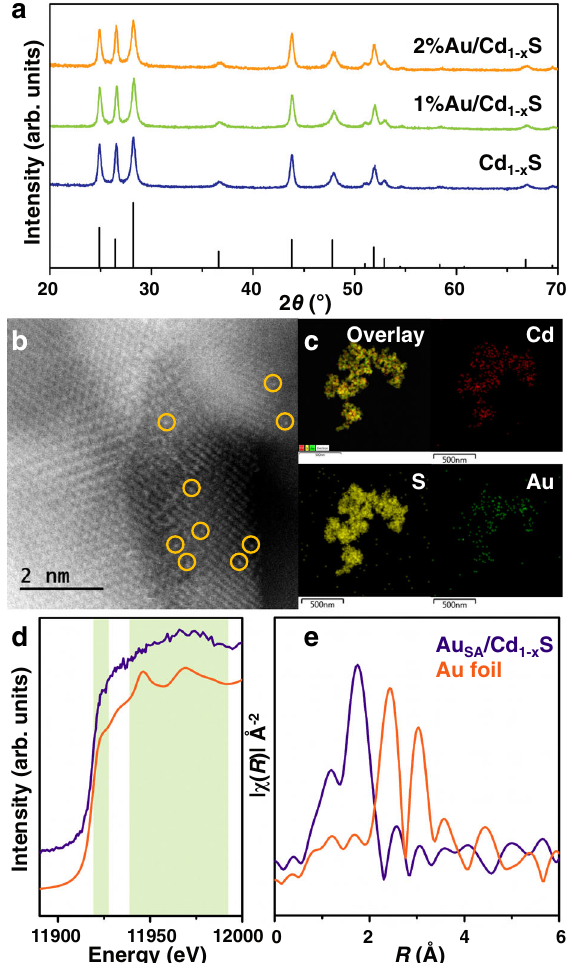
Fig. 2 Characterizations. a XRD patterns of Cd 1-x S, 1%Au/Cd 1-x S, and 2% Au/Cd 1-x S samples. b HAADF-STEM image of 1%Au/Cd 1-x S, single atomic Au sites high-lighted by yellow circles. c Elemental mappings of 1%Au/Cd 1-x S. d XAFS analysis of Au SA /Cd 1-x S: Au L 3 XANES spectra of the sample and the reference foil. e Corresponding k 1 -weighted Fourier transform (FT) EXAFS